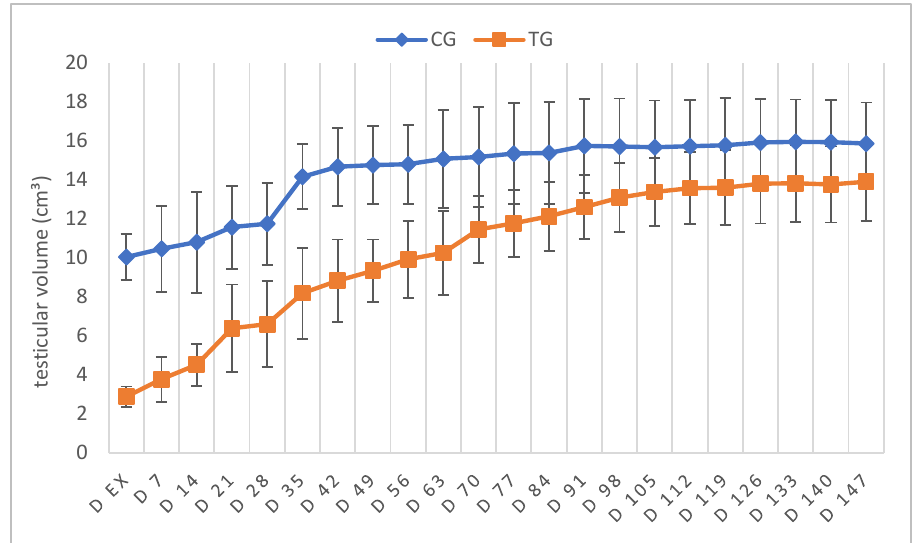
Figure 2. Absolute testicular volume measured by a caliper given as mean ± SD over time; animals treated with a 4.7 mg deslorelin implant (TG, n = 6); saline-treated control animals (CG, n = 3).